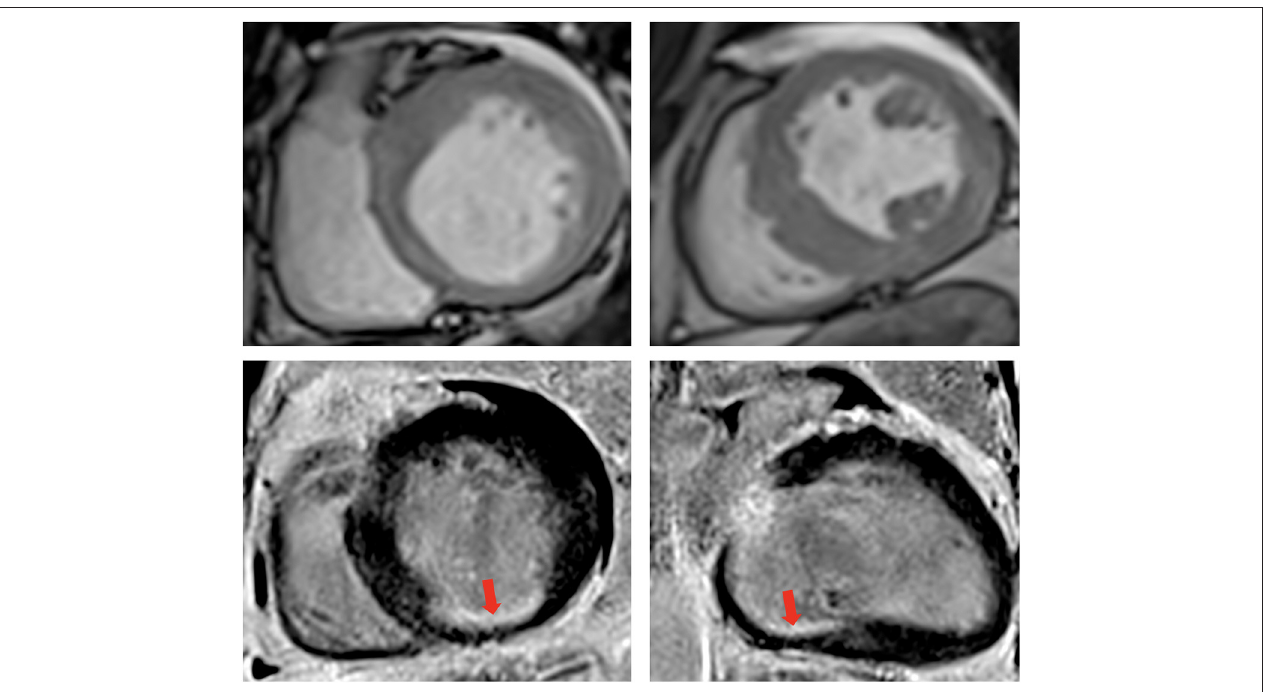
FIGURE 2 | Contrast enhanced cardiovascular magnetic resonance imaging. Cine images diastolic frames in short axis at the base (top left) and at the level of papillary muscle (top right) showing asymmetrical left ventricular hypertrophy. Late Gadolinium enhancement phase sensitive inversion recovery (PSIR) imaging in short axis (Base left) and 2-chambers view (Base right), respectively, showing the subendocardial scar at the base of the inferior wall (red arrow). The transmurality of the scar was reported at 50–75%, however, note that only one segment is infarcted, while the rest of the territory supplied by the right coronary artery is viable.